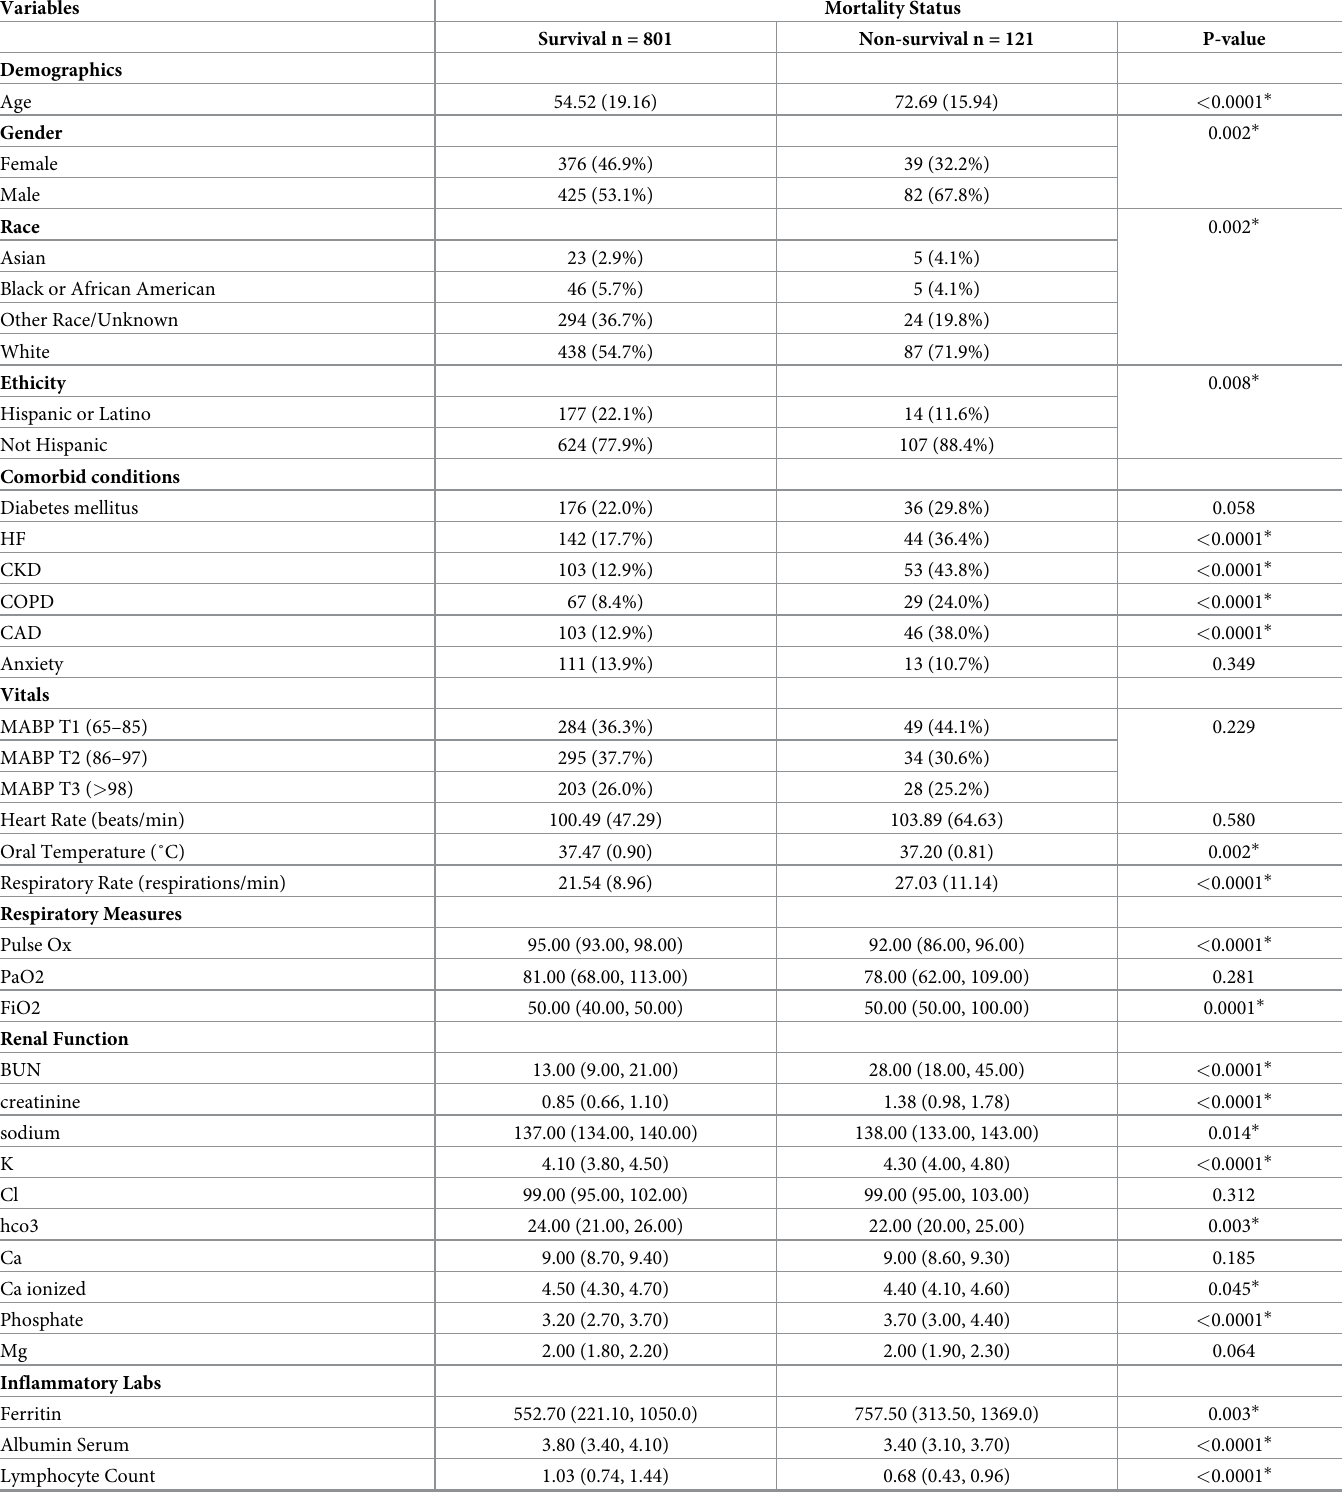
Table 4. Comparison of non-hypertensive COVID-19 positive patients who expired and